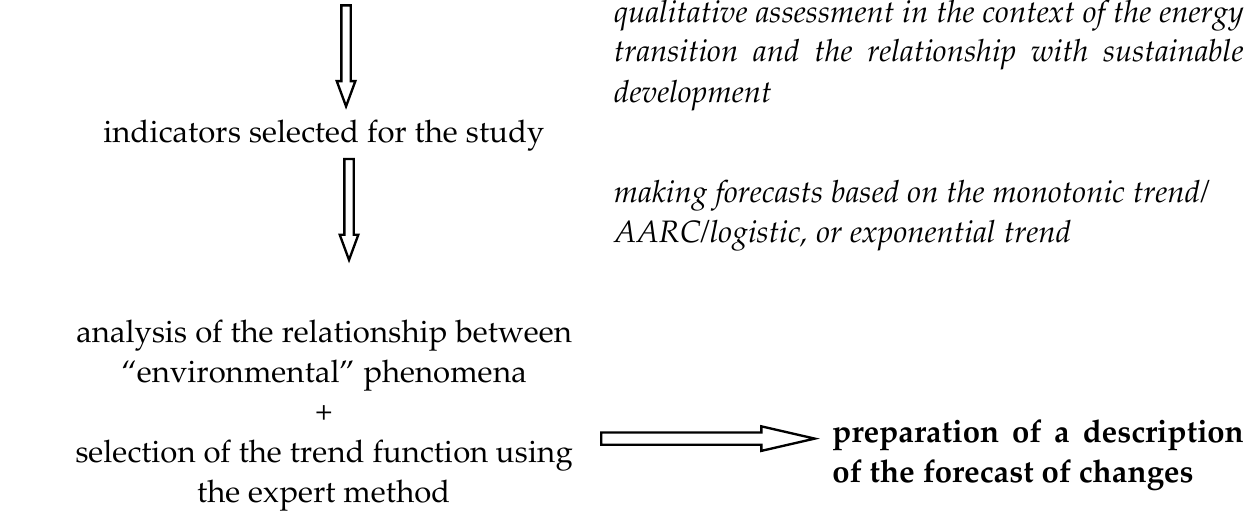
Figure 1. Logic of the research procedure. Source: Own elaboration.